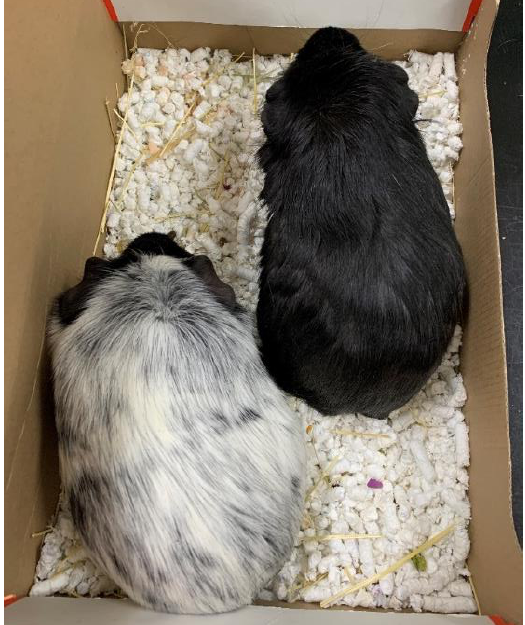
Figure 2. Guinea pigs affected by dermatophytosis with no clinical signs.